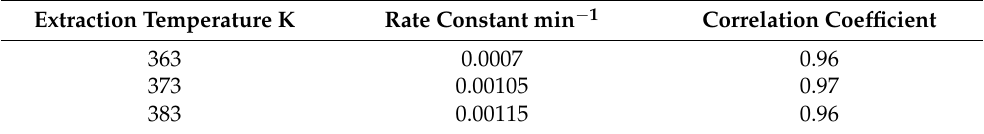
Figure 12. ln k 2 – T − 1 relationship for Co leaching. 4. Conclusions Mixing at a rate of 400 r/min and higher eliminated the effect of liquid boundary layer diffusion. The leaching rates of Ni and Co significantly increased with an increasing tem- perature. The experimental results showed that the leaching rates of Ni and Co were more